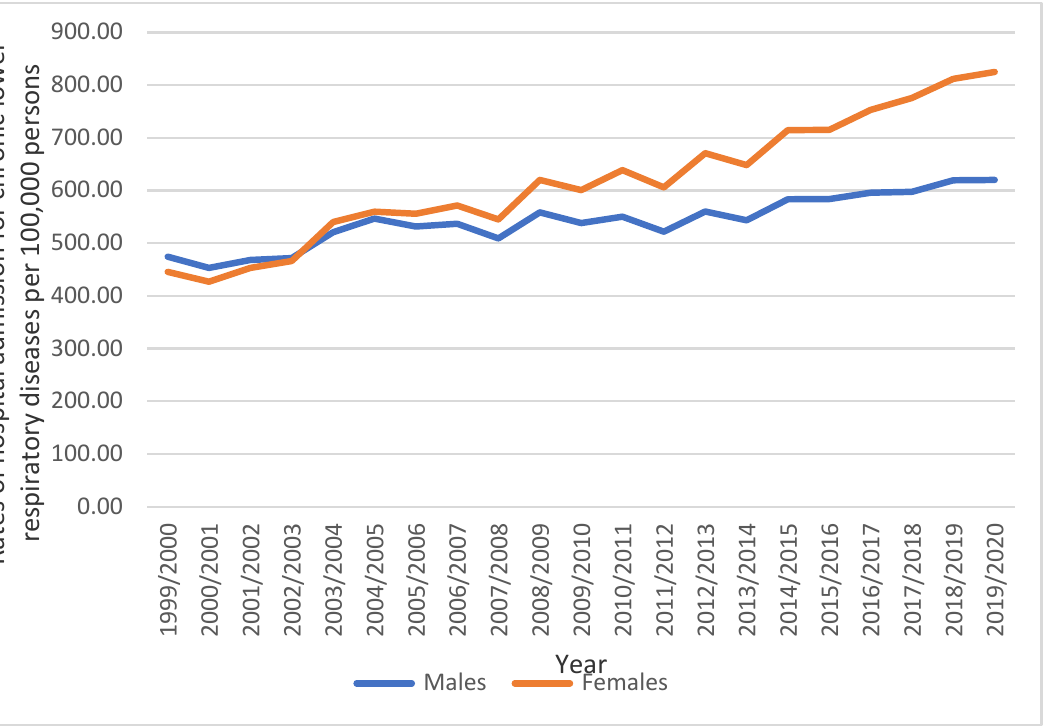
Figure 2. Rates of hospital admission for chronic lower respiratory diseases in England and Wales stratified by age group.